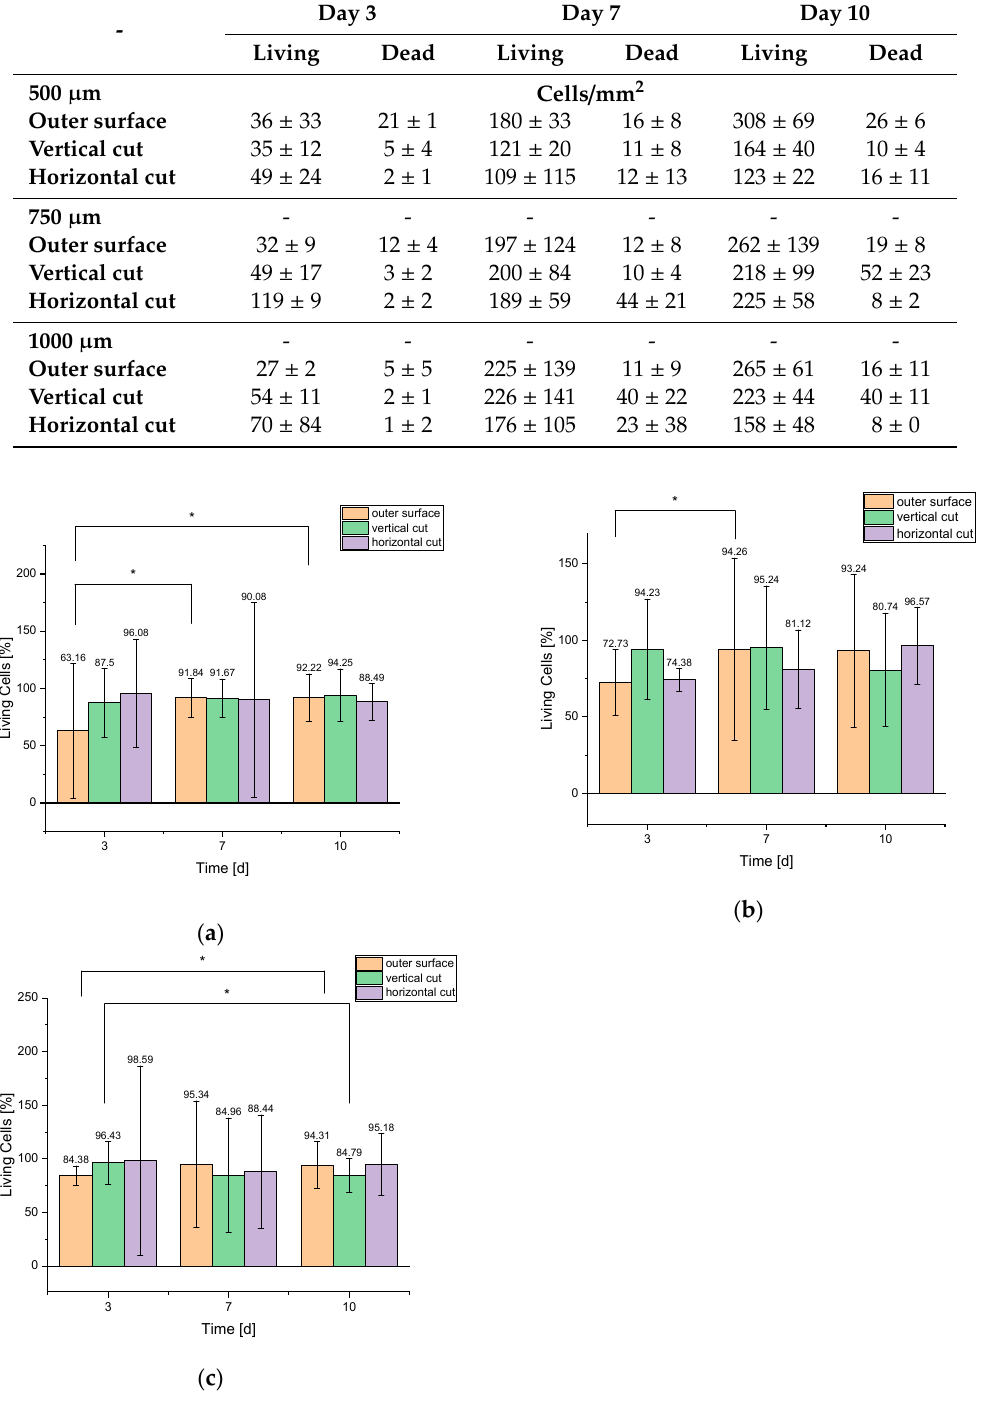
Figure 6. Living cells in percent for the different scaffolds a : 500 µm; b : 750 µm; and c : 1000 µm .